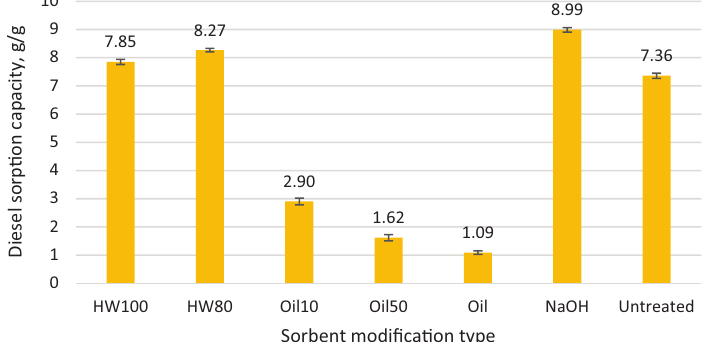
Figure 2. Diesel sorption capacity by mass